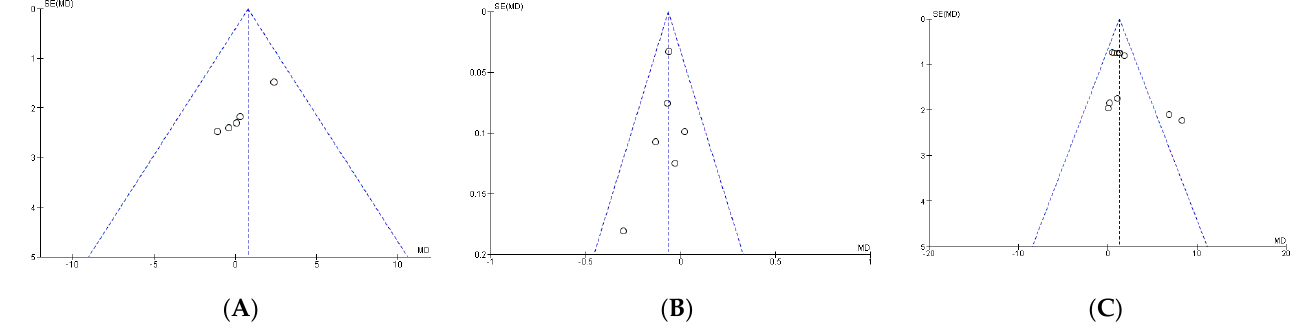
Figure 4. The standard error for throwing speed ( A ), time in sprint tests ( B ), and jump height ( C ). SE: standard error; SMD: standardized median difference.